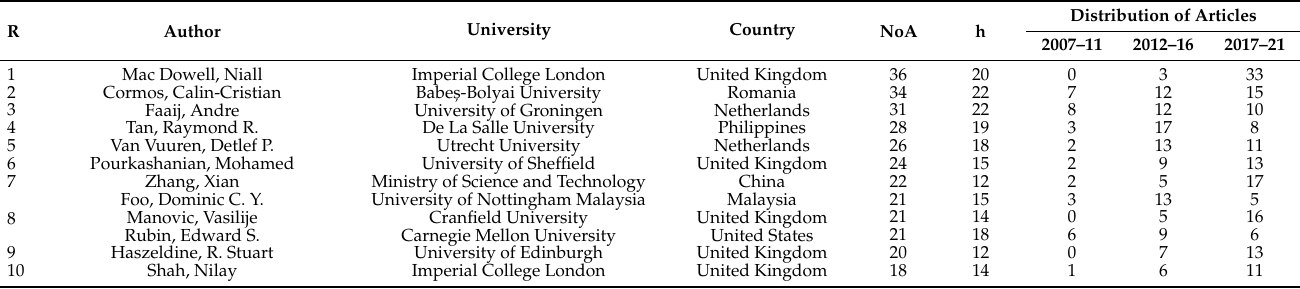
Table 1. Top ten most productive authors based on published articles.